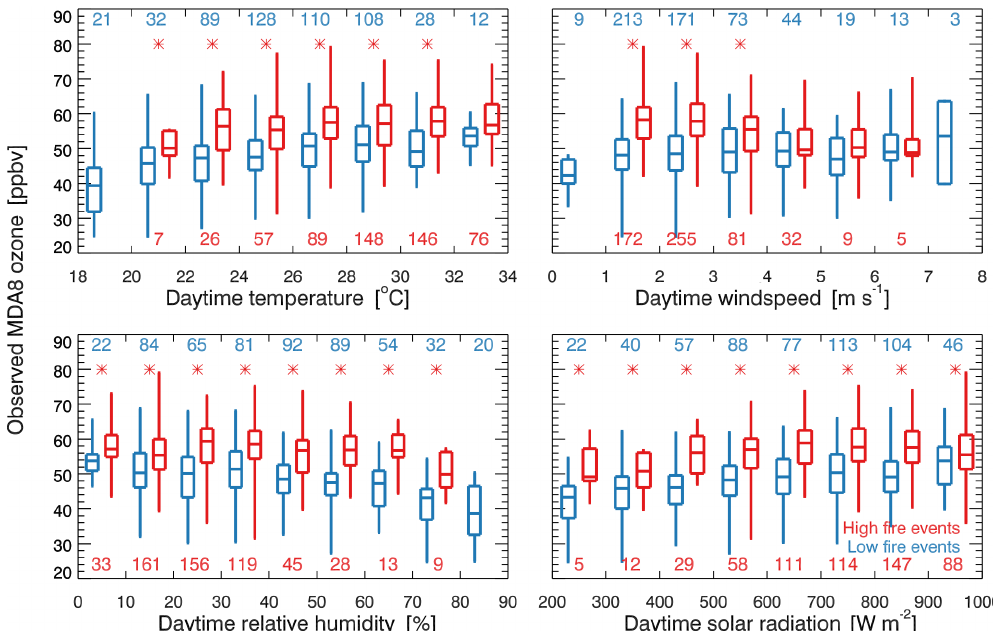
Figure 6. Box-and-whisker plots (minimum, 25th, 50th, and 75th percentiles, and maximum) of observed MDA8 ozone concentrations for bins of observed daytime meteorological parameters at CHA site: temperature (upper-left), wind speed (upper-right), relative humidity (bottom-left), and solar radiation flux (bottom-right). MDA8 ozone concentrations are divided by high (TFI at top 33%, red) and low (TFI at lower 33%, blue) fire events with the number of occurrences in each bin shown inset. Significant difference ( p< 0 . 05) is marked by asterisks.